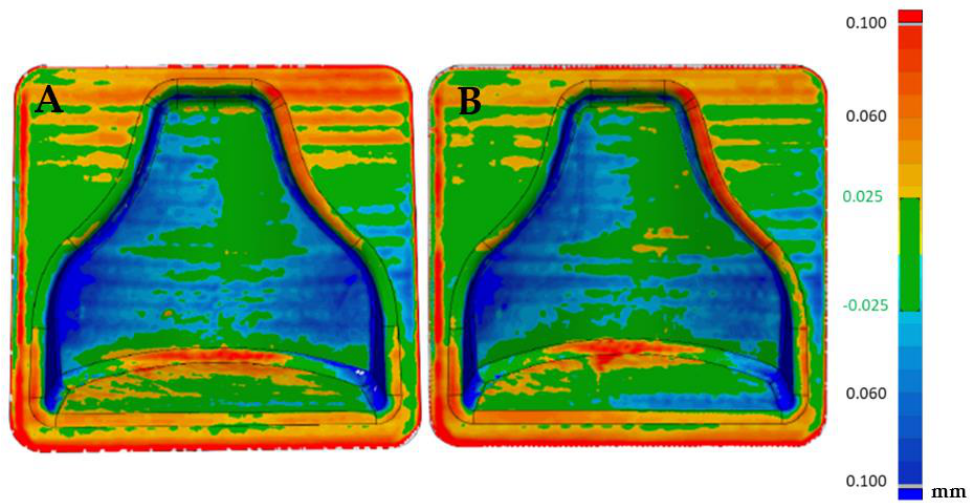
Figure 11. Comparison between the CAD model and first mold after chemical smoothing ( A ) and cad model and second mold after chemical smoothing ( B ).